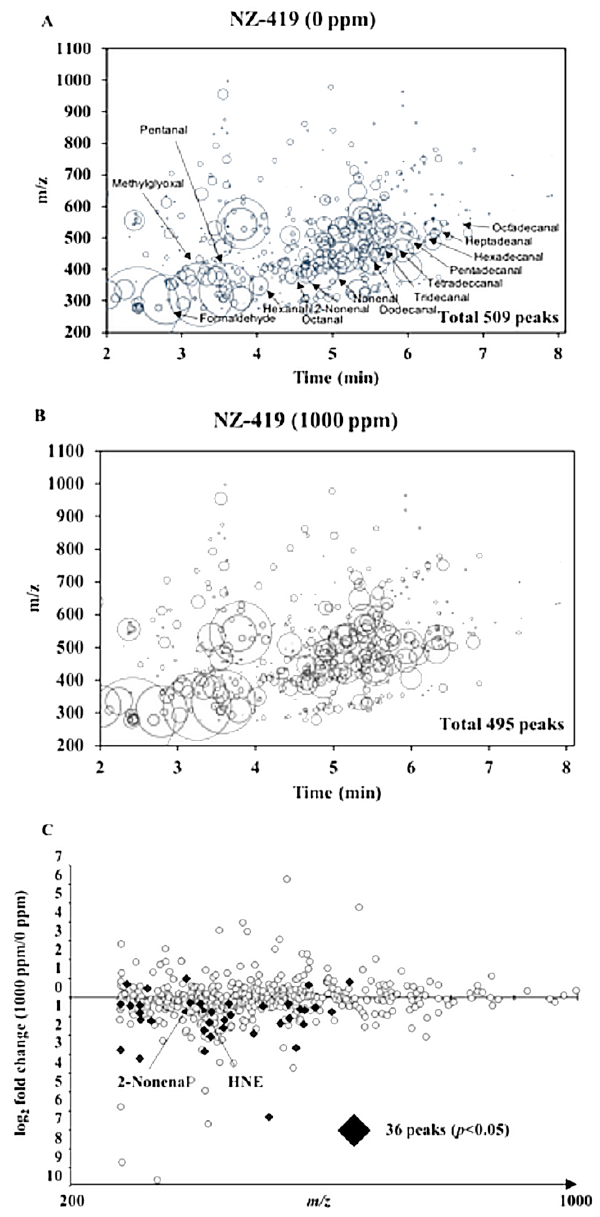
Figure 5. Reactive carbonyl species (RCs) maps plotting free RCs detected in the serum samples of Min mice. All free RCs detected in the serum samples taken from 0 ( A ) or 1000 ( B ) ppm NZ ‐ 419 ‐ treated Min mice are shown. The RCs are plotted as circles as a function of their retention times (horizontal axis) and m / z values (vertical axis). The areas of the circles represent the intensities of the peaks of the RCs relative to that of the internal standard (IS). The RCs abbreviations are listed in the Materials and Methods section. ( C ) The comparative RCs profiles of the serum samples from 1000 ppm NZ ‐ 419 ‐ treated Min mice. The closed diamonds indicate that the RCs levels were significantly different between non ‐ treated and NZ ‐ 419 ‐ treated mice ( p < 0.05).